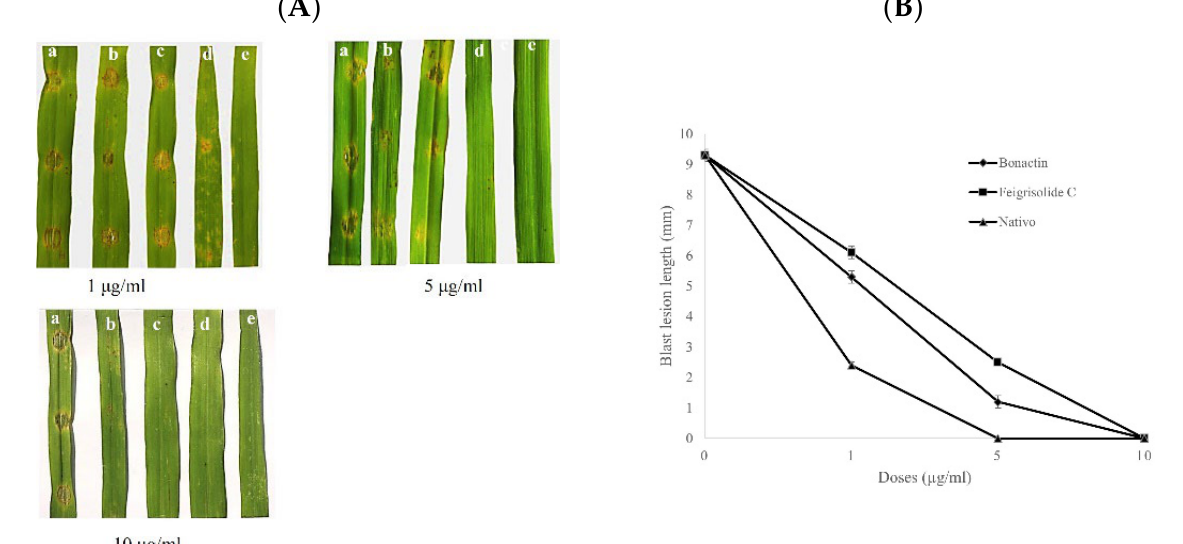
Figure 5. ( A ). Representative images showing wheat blast disease (symptoms) suppression by varying doses (1–10 µ g/mL) of bonactin, feigrisolide C, and Nativo ® WG75. The compounds were liquefied in 1% DMSO and applied on the detached leaves of wheat (cv. BARI Gom 26) 24 h before artificial point inoculation with 20 µ L/point of suspension of conidia containing 1 × 10 5 conidia/mL. (a) Control, 1% DMSO, (b) bonatin, (c) feigrisolide C, (d) Nativo ® WG75, and (e) uninoculated and untreated leaf. ( B ) Average lengths of blast lesions on detached wheat leaves pretreated with bonatin, feigrisolide C, and Nativo ® WG75 compared to 1% DMSO treatment control. The data are the means ± standard errors of at least five replications for each dosage of the compounds at p ≤ 0.05. Vertical bars represent ± standard error.